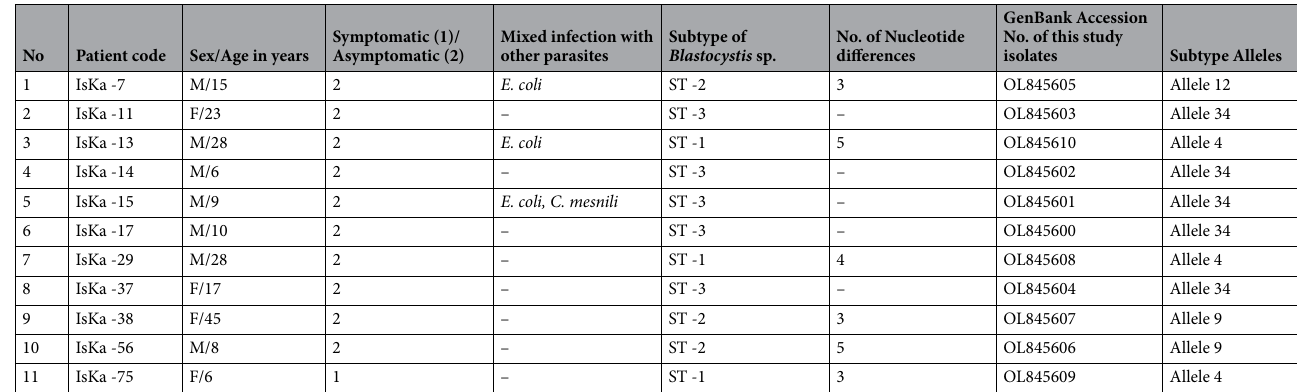
Table 5. The distribution of Blastocystis sp. genotypes and genetic diversity among the 11 sequenced isolates from West Ismailia. IsKa: Ismailia–Kassassin; E. coli : Entamoeba coli ; C. mesnili : Chilomastix mesnili . M: male; F: Female.